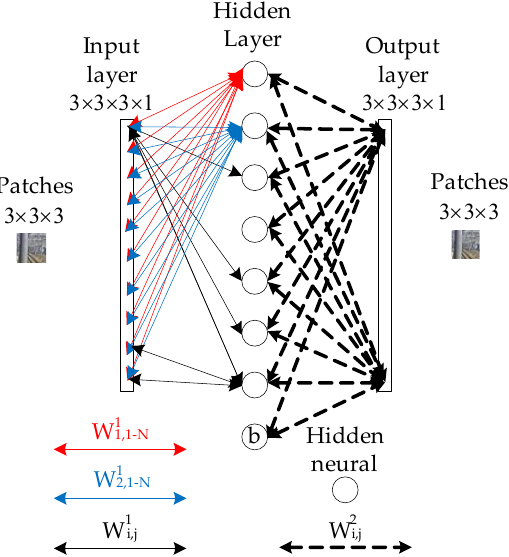
Figure 10. Structure of the autoencoder-decoder network. The hidden layer contains 70 hidden neurons; W denotes the weight associated with the connection between neurons; and the network is trained to produce output the same as its input.